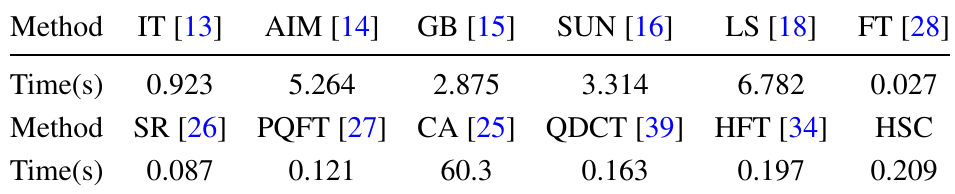
Table 1. Average time cost to compute a saliency map for an image in two datasets [1,26].